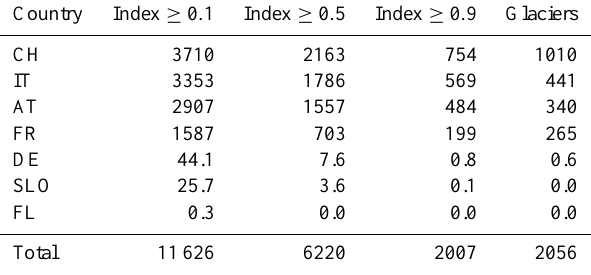
Table 7. Estimated permafrost index areas (km 2 ) for the Alpine countries using different index values, and comparison to glacier area (CH: Switzerland, IT: Italy, AT: Austria, FR: France, DE: Ger- many, SLO: Slovenia, FL: Liechtenstein).